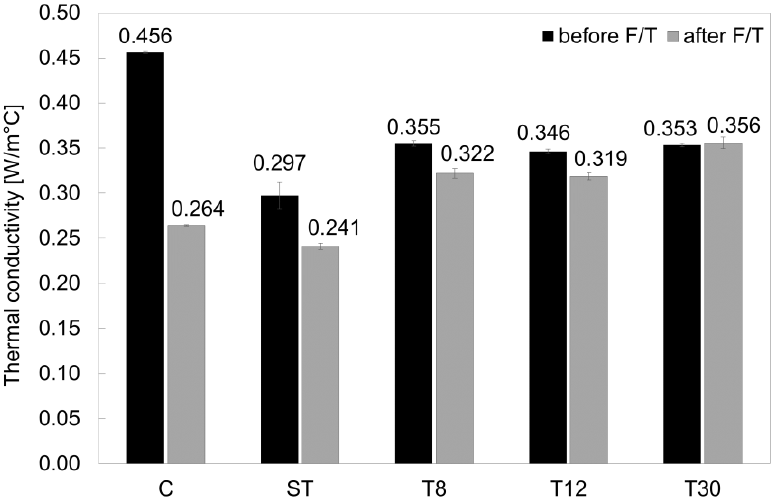
Figure 12. Thermal conductivity values of series C, ST, T8, T12 and T30 before and after freeze/thaw cycles. The error bars represent the standard deviation.